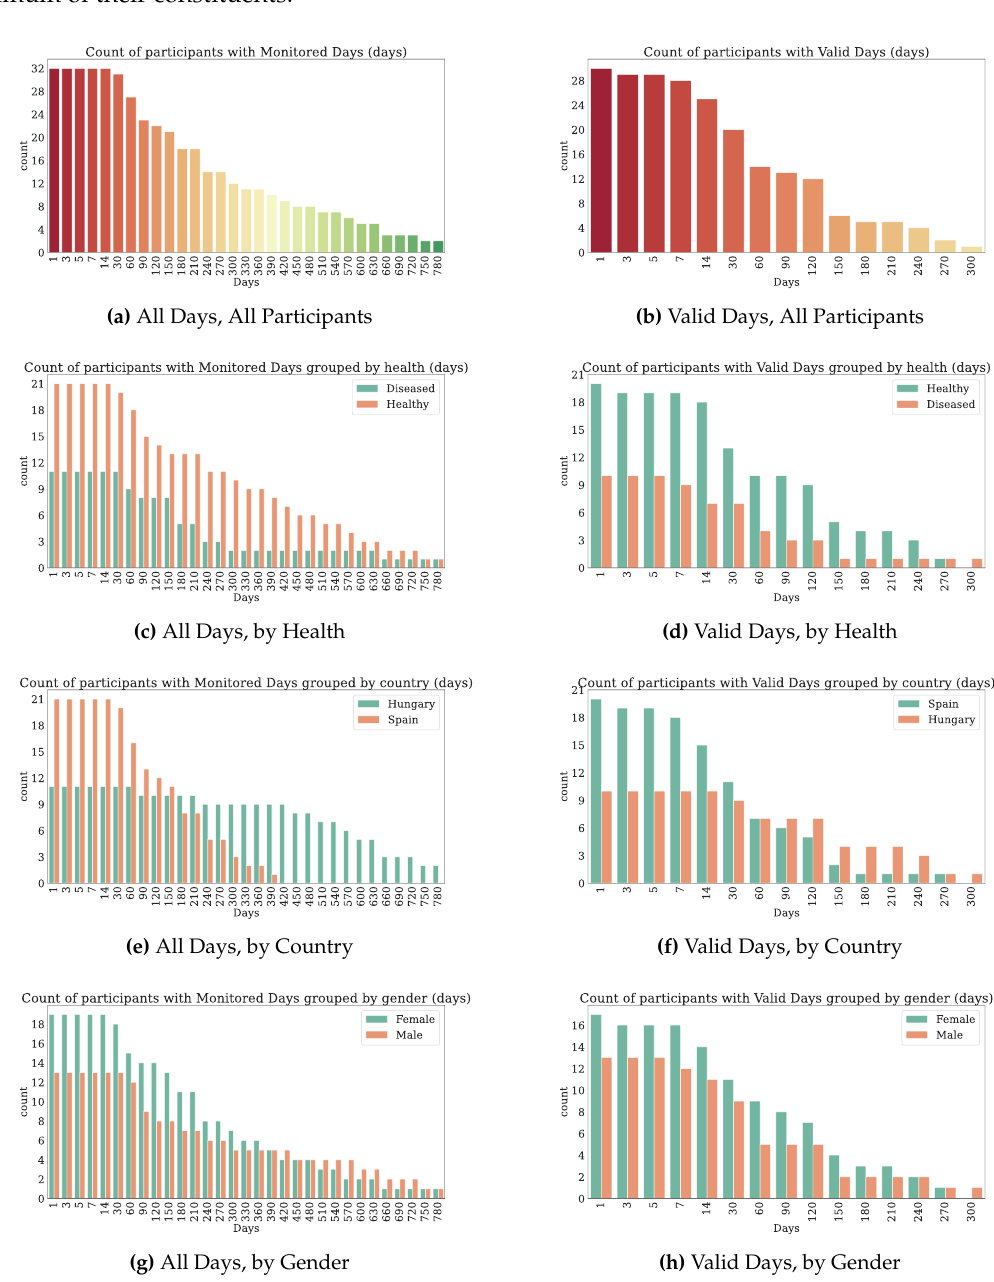
Figure A11. Count of seniors with at least the given valid days of Fitbit (TechRO) by group